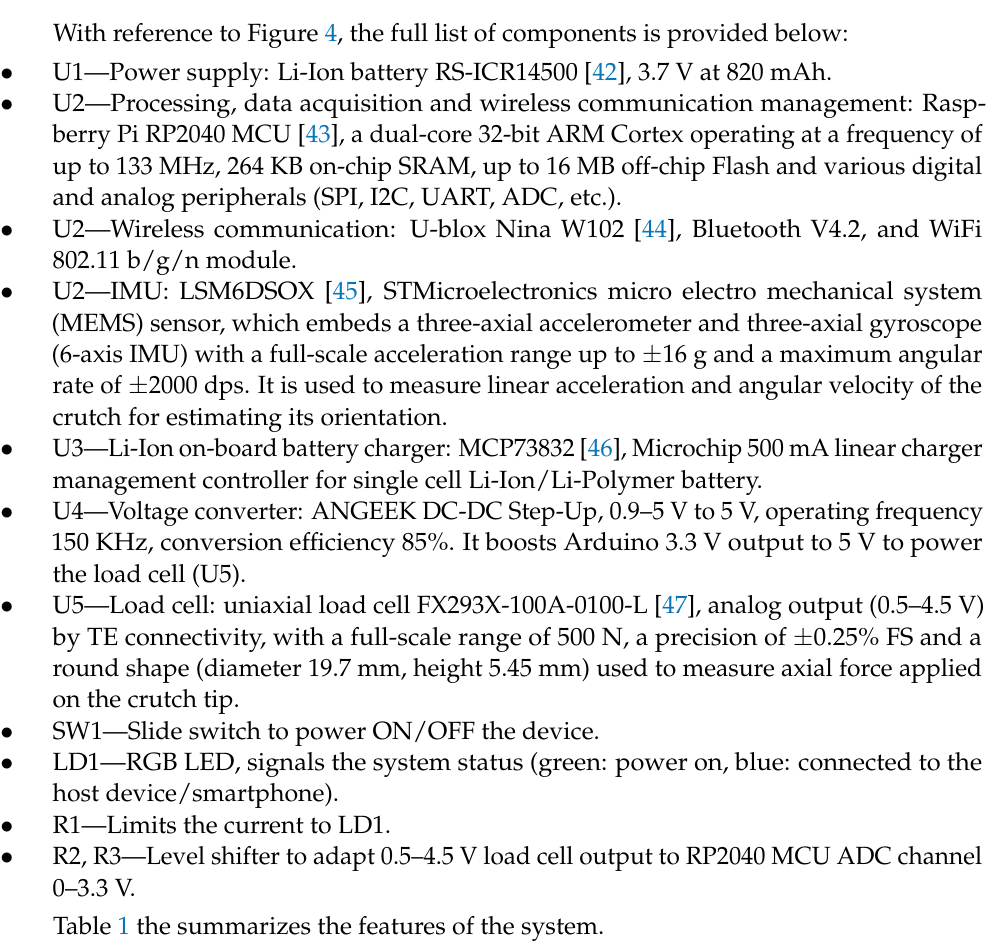
Figure 4. Diagram of electronic connections.